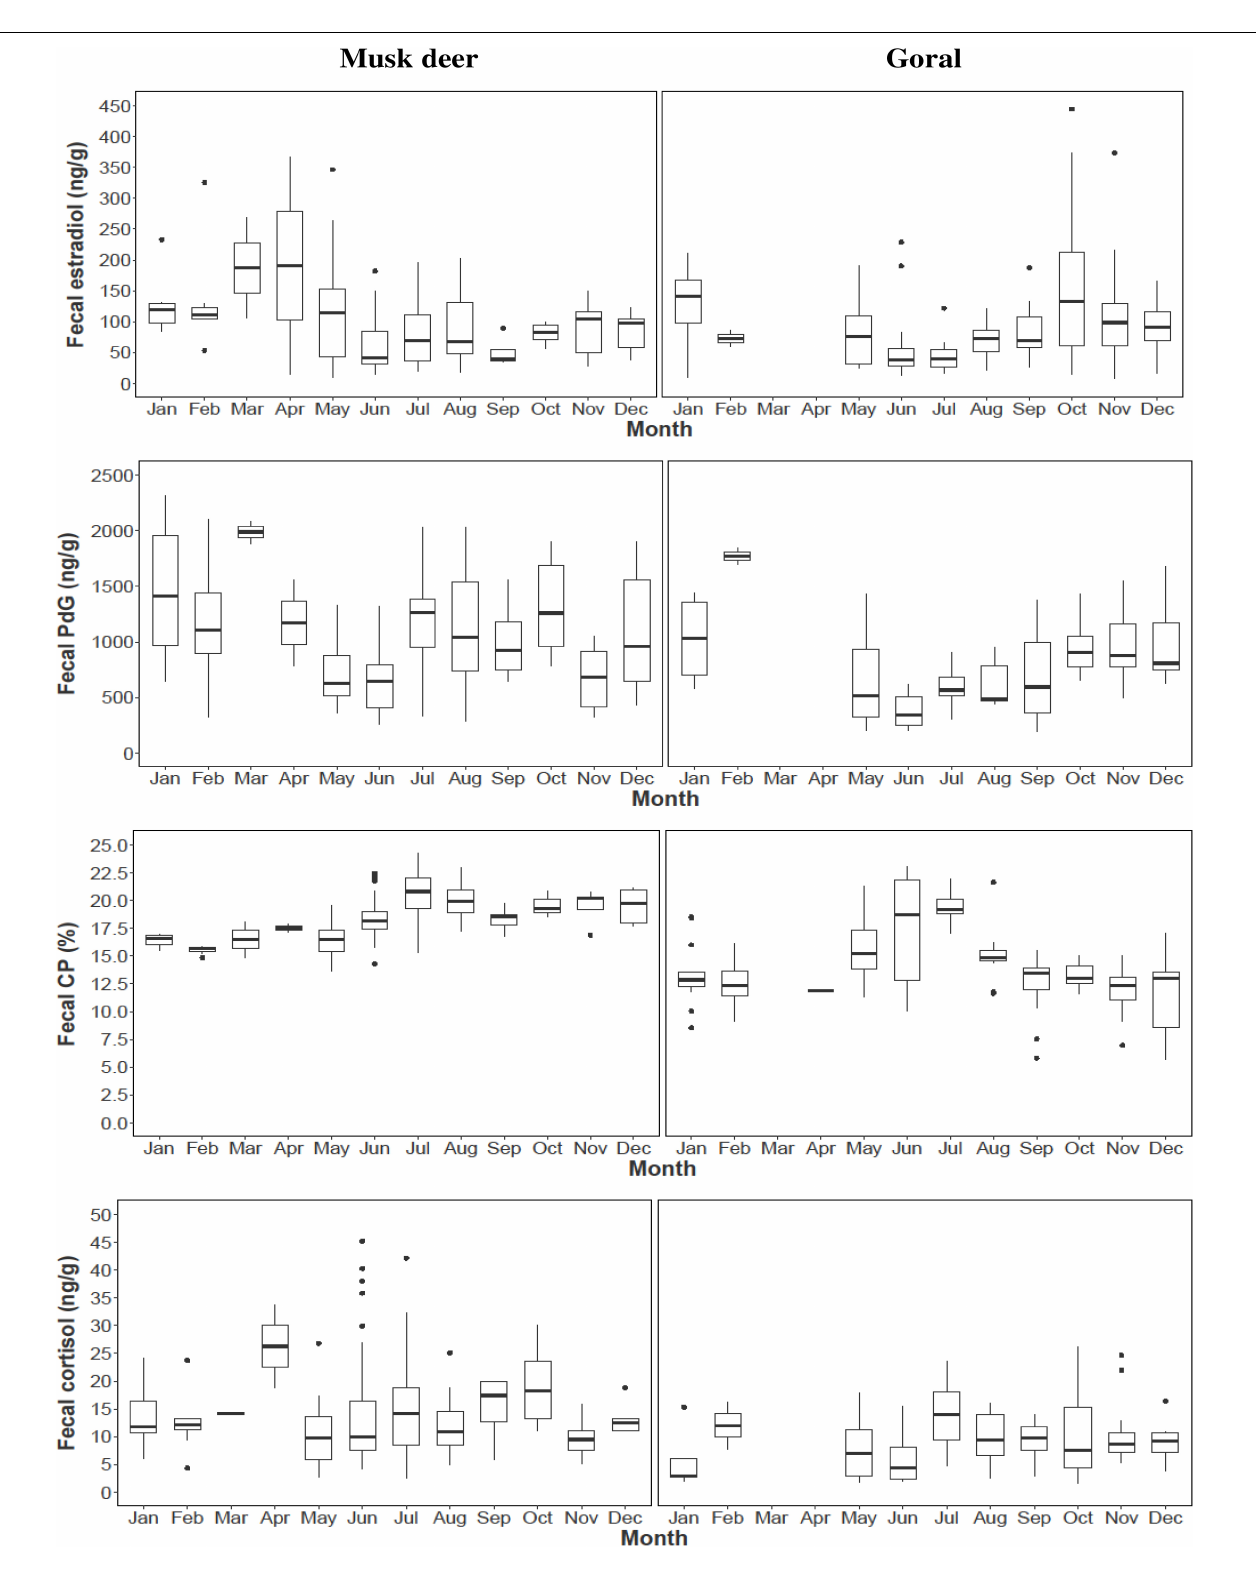
FIGURE 5 | Monthly variations in fecal hormone metabolite concentrations and fecal CP in musk deer and goral. Box represents the interquartile range; horizontal line in the middle of the box is the median and the whiskers are the variability outside the upper and lower quartiles.